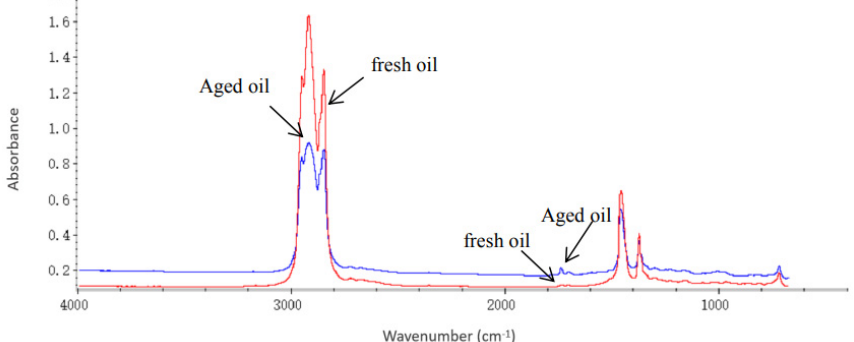
Figure 6. FTIR Spectral Analysis of Fresh and Aged Oil [35].